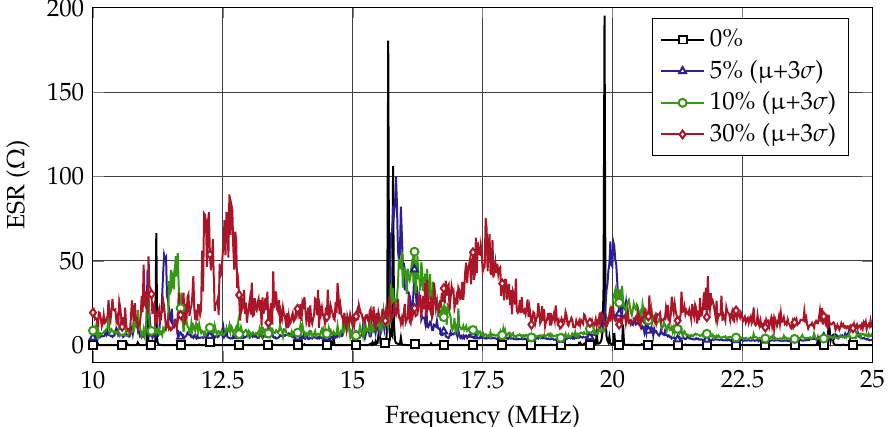
Figure 5. Comparison of ESR extracted from the 2D simulation model with increasing composi- tion percentages of inclusions. Here, the upper bound limit (99% confidence interval) of ESR from mean and standard deviation is considered, and the lower bound is ignored. Considerable sup- pression of acoustics is observed here, with a tolerable increase in ESR at non-acoustic frequencies. A shift in frequencies of acoustics to higher frequencies is also observed with increasing amounts of LDK